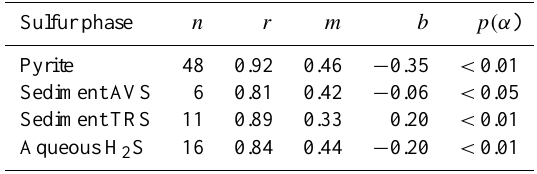
Table A1. Regression statistics for reduced sulfur phases (0– 40PSU only; see Fig. A3).